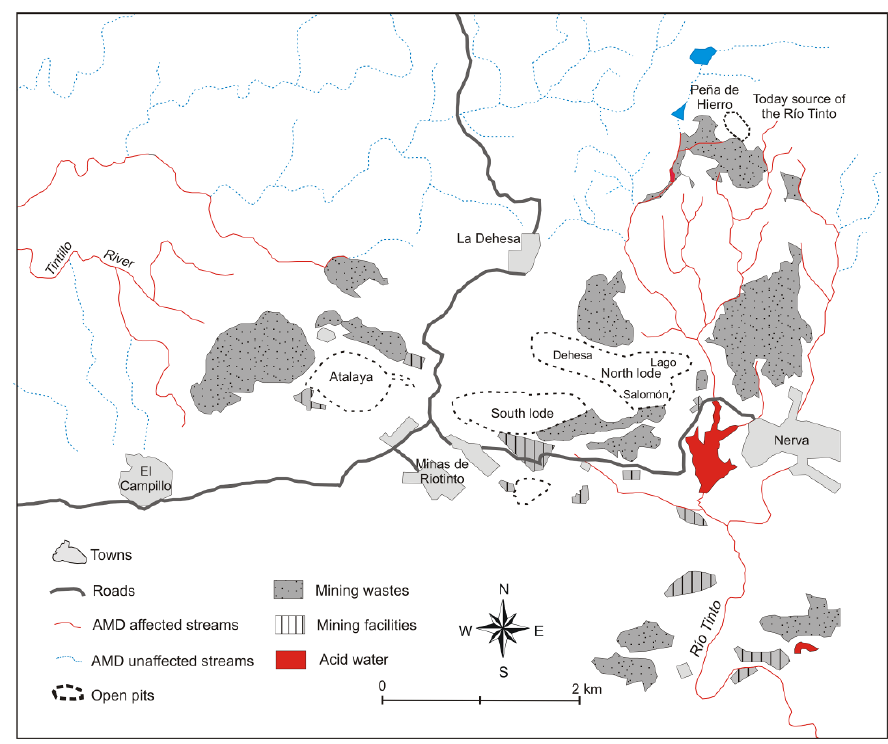
Figure 7. Reconstruction of the impact of mining in the Río Tinto headwaters in 1960. Location of mining wastes and facilities have been taken from [38]. The represented area corresponds to the inner square in Figure